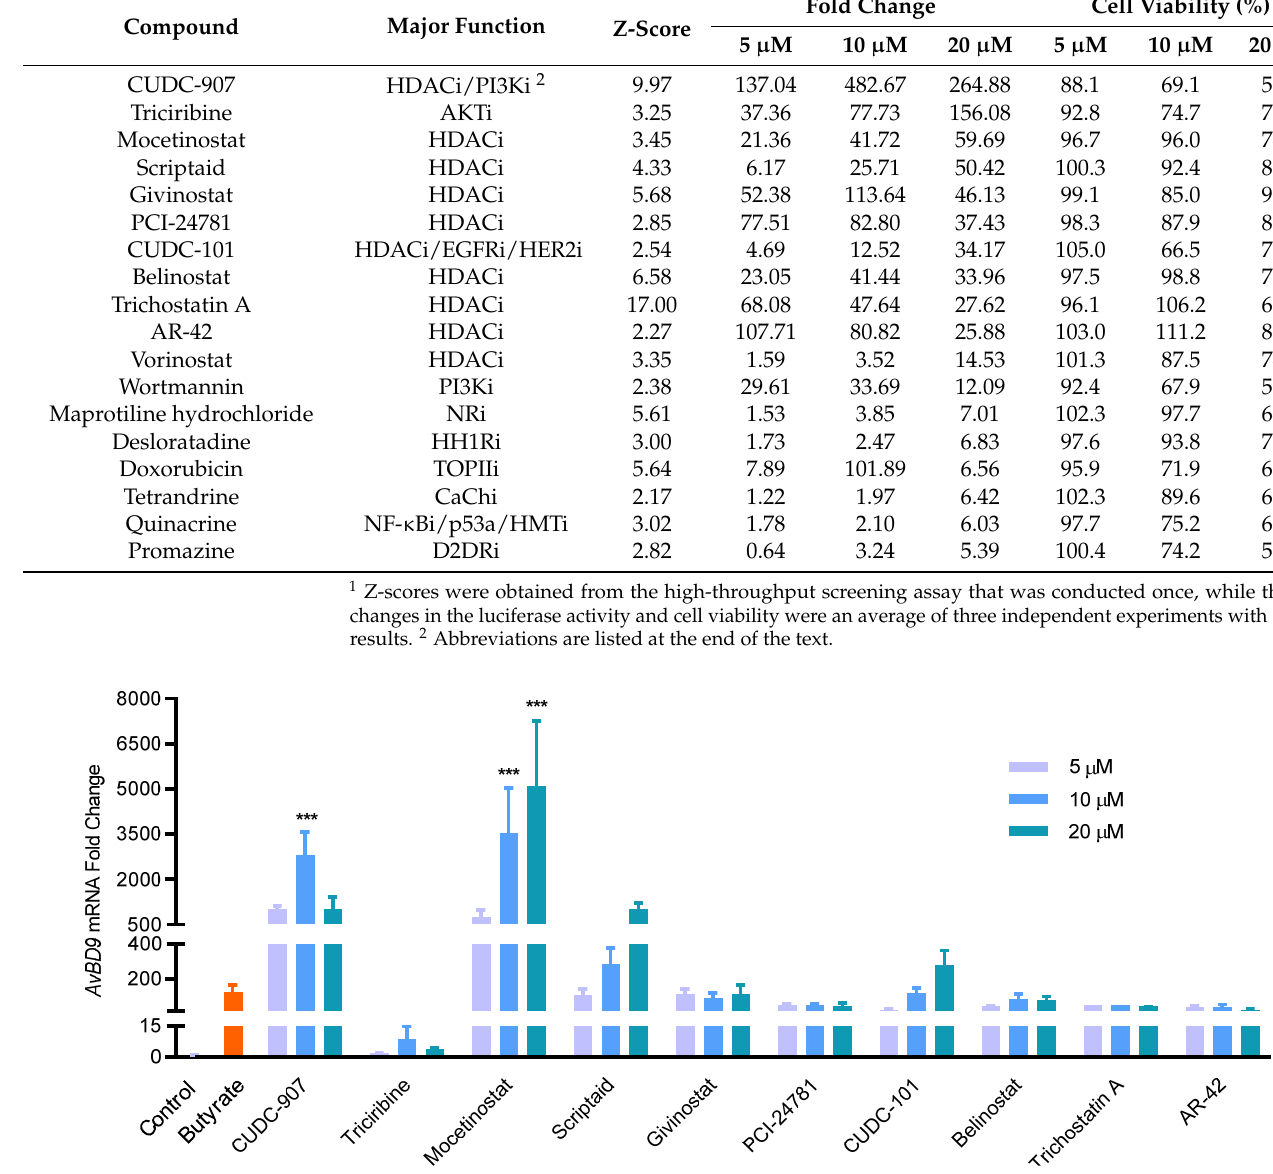
Figure 2. Dose-dependent induction of AvBD9 mRNA expression in chicken HTC cells in response to ten leading HDP inducers. HTC cells were stimulated in duplicate using different concentrations of each compound for 24 h, followed by RT-qPCR analysis of AvBD9 mRNA expression. Sodium butyrate (4 mM) was used as a positive control and an equal volume of solvent as a negative control. The results are means ± SEM of three independent experiments. One-way ANOVA was performed, followed by Dunnett’s test. *** p < 0.001 (relative to the unstimulated